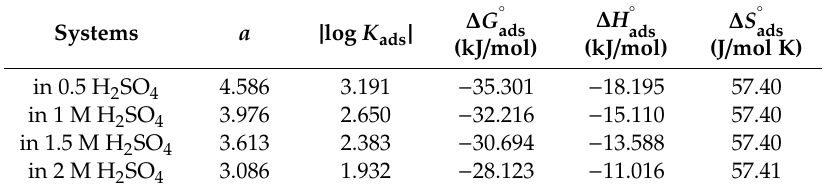
Table 6. The thermodynamic parameters for inhibitor adsorption on the 304 SS surface at ambient temperature (25 ◦